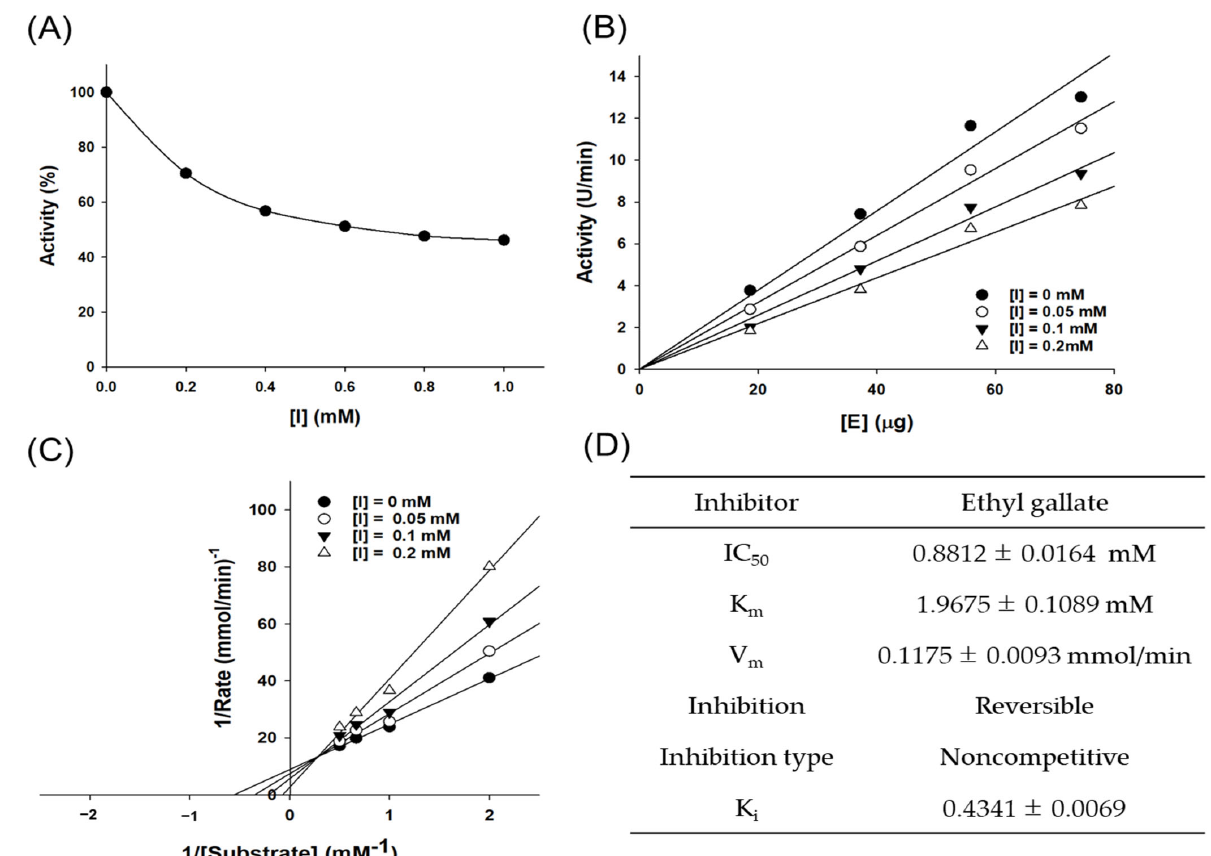
Figure 6. ( A ) Effect of EG on tyrosinase activity. ( B ) Tyrosinase–EG concentration relationship in catalytic activity. EG concentrations for curves 1–4 were 0, 0.05, 0.1, and 0.2 mM, respectively. ( C ) Lineweaver–Burk plots for EG inhibition on tyrosinase. EG concentrations for curves 1–4 were 0, 0.05, 0.1, and 0.2 mM, respectively. ( D ) Kinetic parameters and microscopic inhibition rate constants of mushroom tyrosinase in the presence of EG.